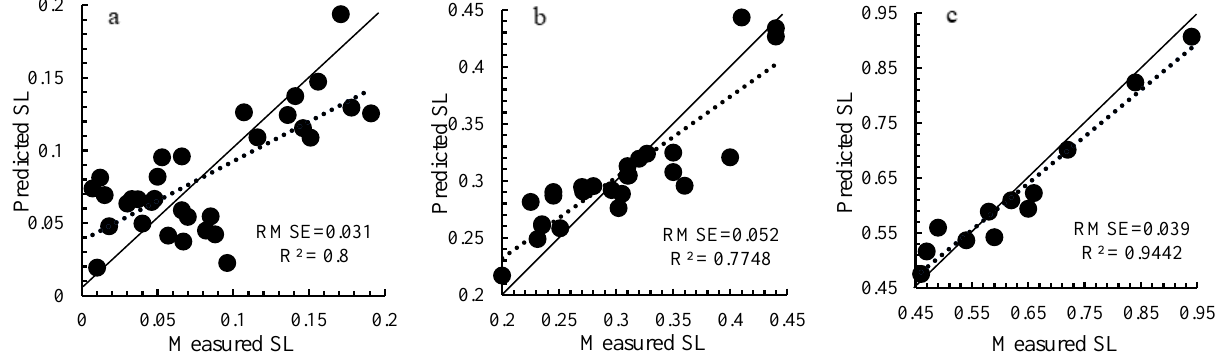
Figure 8. Optimal monitoring model of wheat stripe rust under different disease severity. ( a ) Mild disease stage with SIF tot as independent variable, ( b ) intermediate disease stage with SIF canopy as an independent variable, and ( c ) severe disease stage with NIR V P as independent variable. Solid line represents 1:1 and dotted line represents the regression line between measured and predicted SL.